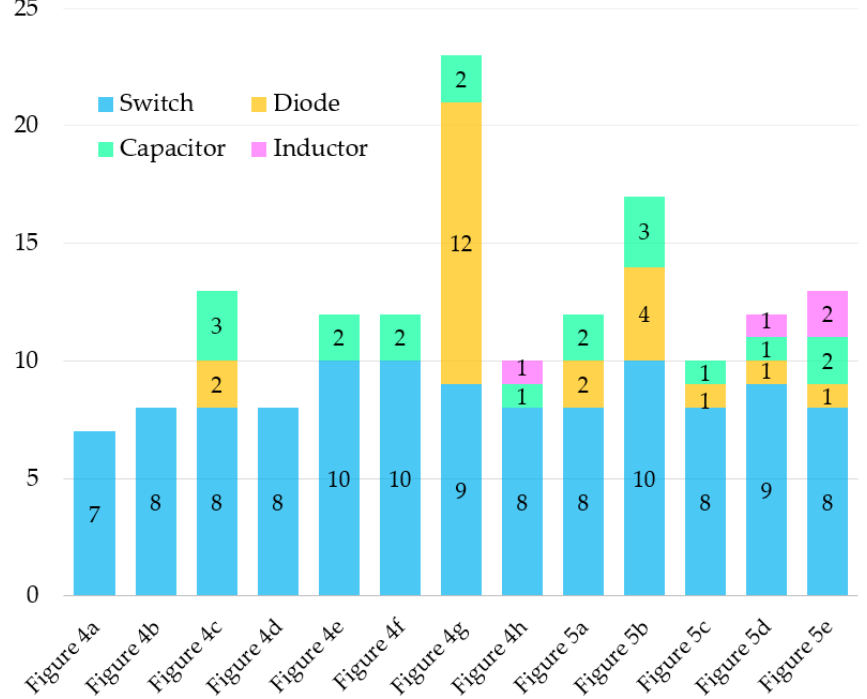
Figure 6. The components for topologies enlisted in Table 2.